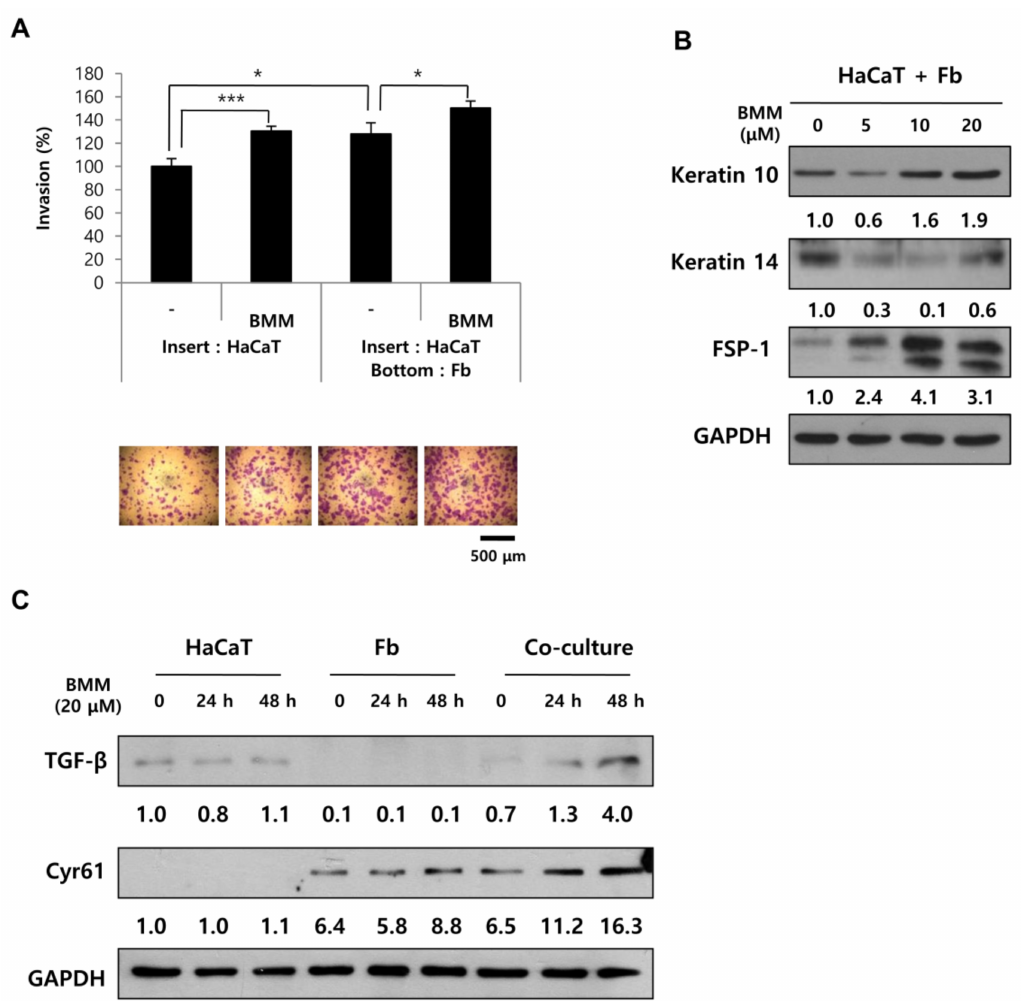
Figure 5. In co-culture, BMM further stimulates the migratory ability of HaCaT cells through the secretion of TGF- β and Cyr61 from HaCaT and Fbs, respectively. ( A ) Transwell invasion assay of HaCaT cells after BMM treatment. For single culture, only 7 × 10 4 cells of HaCaT were seeded on the insert, and an equal number of Fbs were cultured on the bottom at the same time for co-culture. After crystal violet staining, invasive ability was measured using the ImageJ program; ( B ) Western blotting for co-cultured cells to detect differentiation of HaCaT (K10) or Fbs cells (FSP-1). The values indicate intensities of protein expression with respect to that of the loading control; ( C ) The expression of TGF- β and Cyr61 on HaCaT, Fbs, and co-cultured cells using western blotting. The values indicate intensities of protein expression with respect to that of the loading control. * p < 0.05 and *** p < 0.001 as compared to the